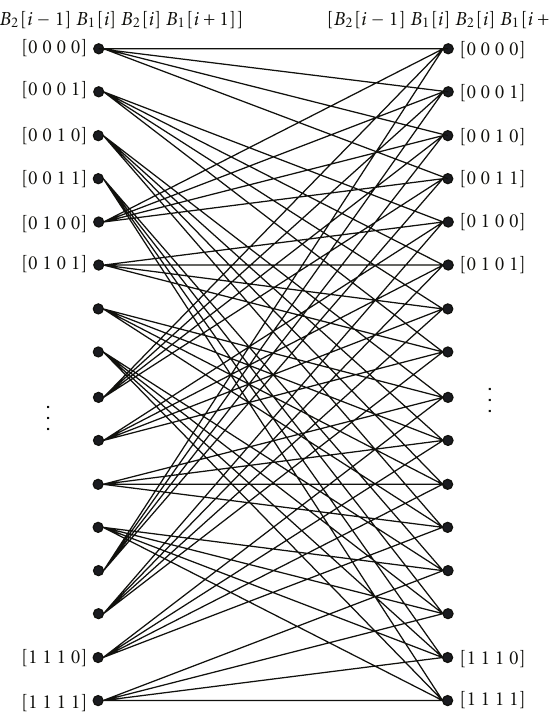
Figure 7: Trellis connectivity.